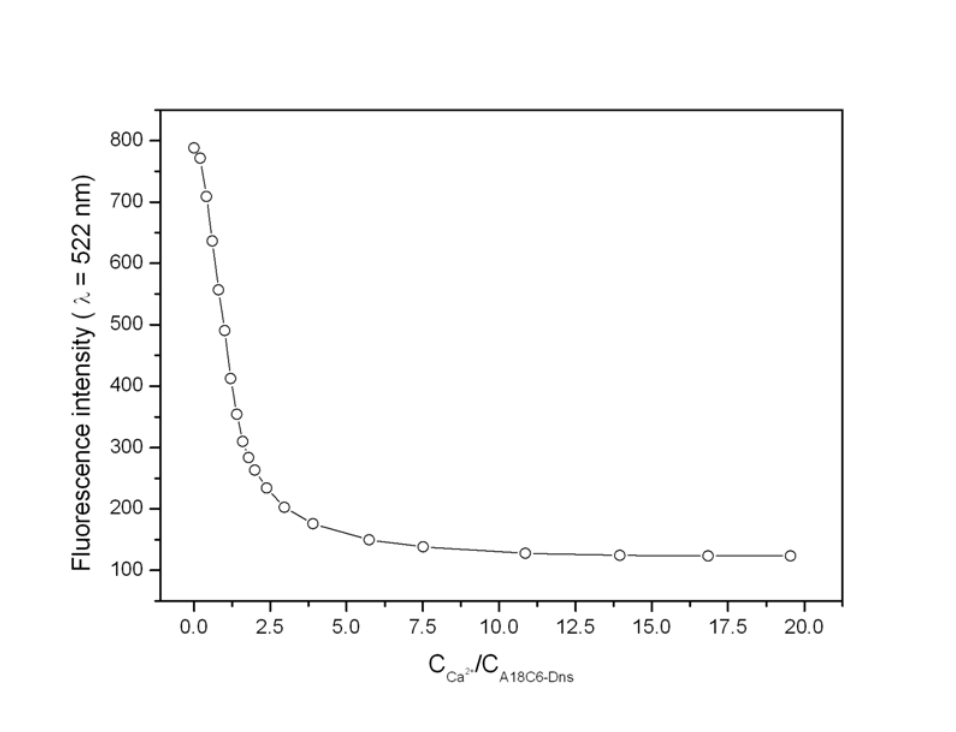
Fig. 4b Fluorescence intensity at 522 nm as a function of molar ratio C Ca 2+ /C A 18 C 6 − Dns .